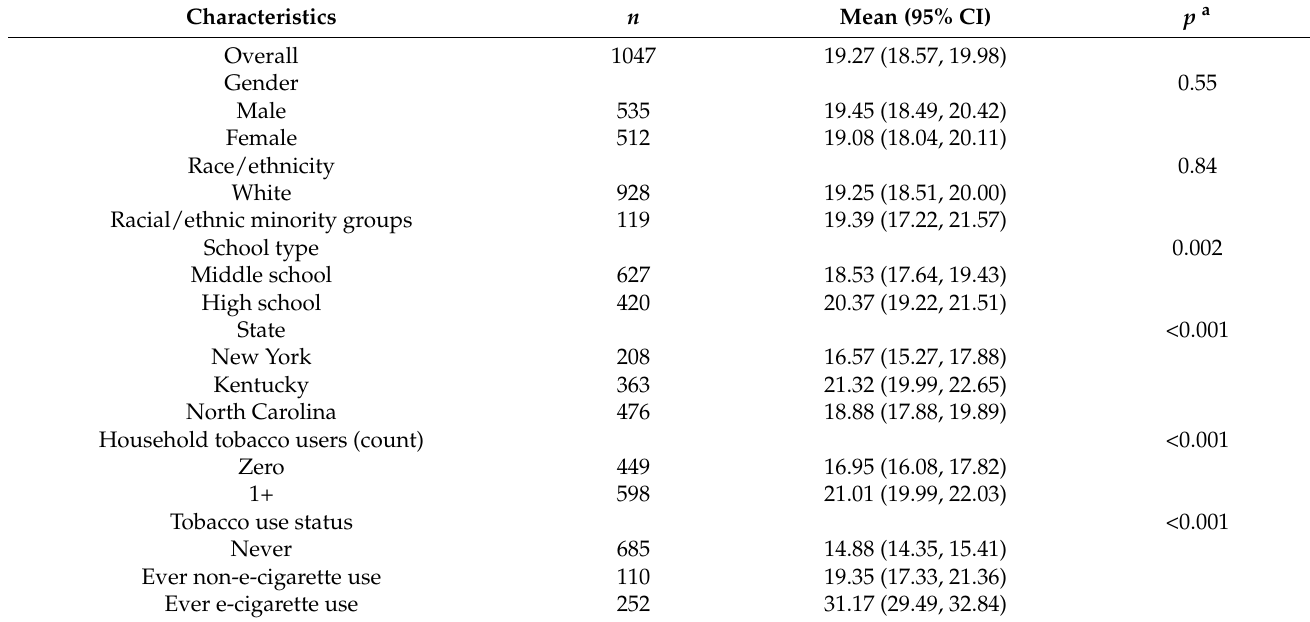
Table 2. Distribution of the E-cigarette Use Temptation Scale by Sociodemographic